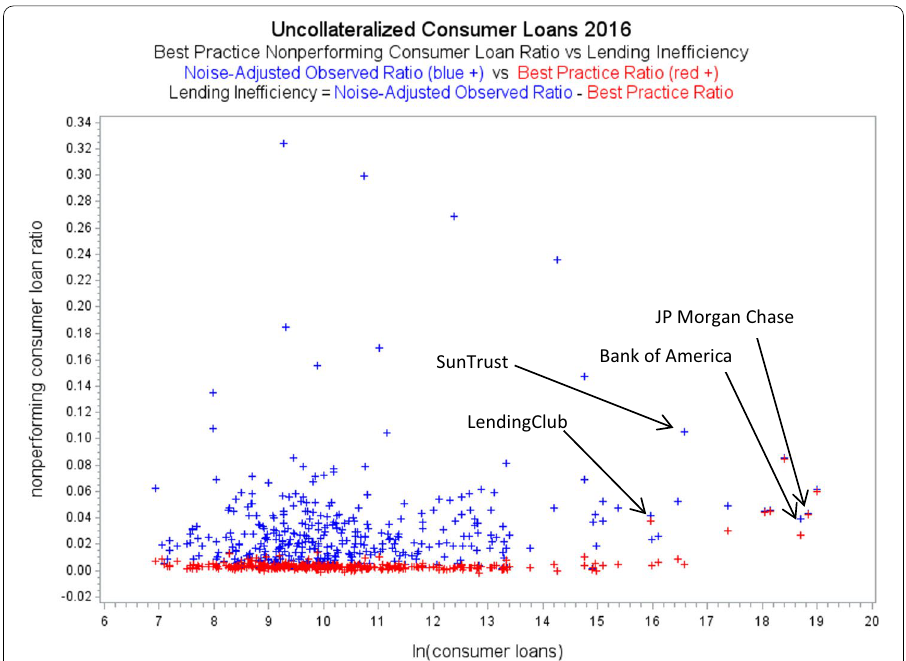
Fig. 2 Nonperforming consumer loan ratio, best practice ratio, and lending inefficiency: 2016, controlling for the loan